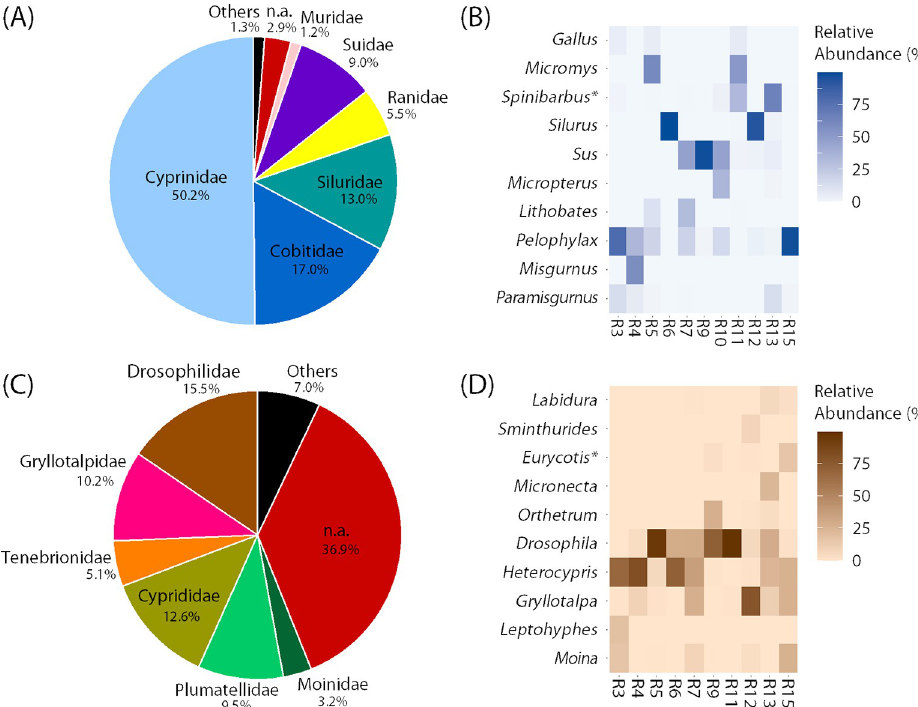
Fig 2. Dietary composition of raccoon dogs. (A) Mean relative abundance of vertebrates at the family level as measured by 12S rRNA gene sequencing. The data obtained using the blocking oligonucleotide RacBlk are shown. The sequence reads identified as the family Canidae were excluded from the calculation for relative abundance. (B) Relative abundance of the 10 most abundant vertebrate genera detected by 12S rRNA gene sequencing with RacBlk. The unidentified reads at the genus level and genera belong to the family Canidae were excluded from the calculation for relative abundance. (C) Mean relative abundance of invertebrates at the family level as measured by 16S rRNA gene sequencing. The sequence reads assigned to non-targeted organisms such as bacteria and vertebrates were excluded from the calculation for relative abundance. (D) Relative abundance of the 10 most abundant invertebrate genera detected by 16S rRNA gene sequencing. The unidentified reads at the genus level and reads assigned to non-targeted organisms such as bacteria and vertebrates were excluded from the calculation for relative abundance. The abbreviation “n.a.” represents the ambiguous reads were not classified into specific family. The detection of Spinibarbus and Eurycotis (with � ) may be misidentification (see text for